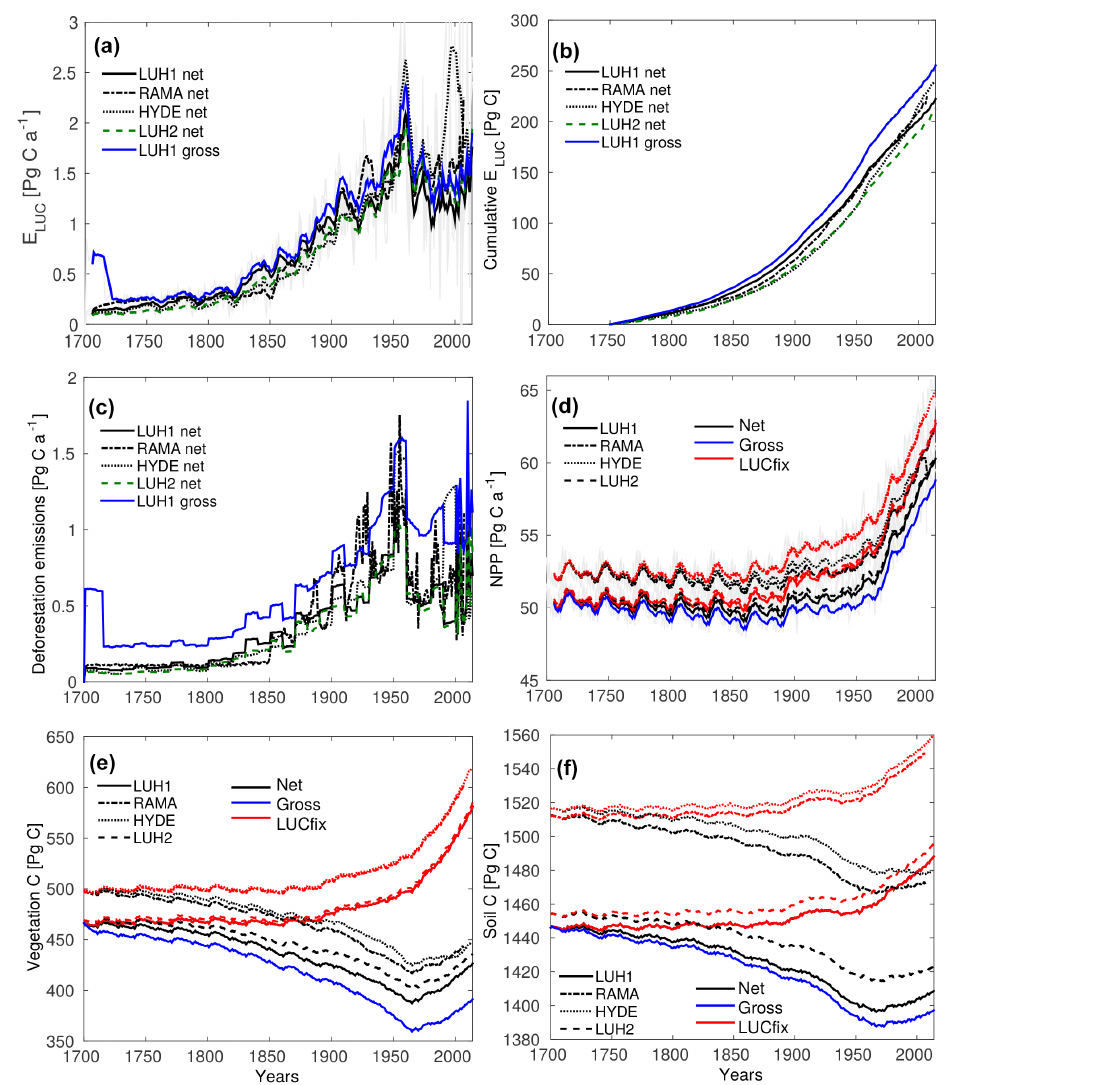
Figure 2. Effects of different land-use representations on global ecosystem C stocks and fluxes: land-use flux (a) , cumulative land-use flux (b) , deforestation emissions (c) , net primary productivity (NPP) (d) , vegetation (e) and soil carbon stocks (f) . Flux values in (a) and (d) are given as 15-year averages with original values in the background. NPP, vegetation and soil C is shown for simulations experiencing net (or gross) LUC and in addition for simulations where LUC was kept at 1700 levels (see the “Methods” section; red lines in d, e, f